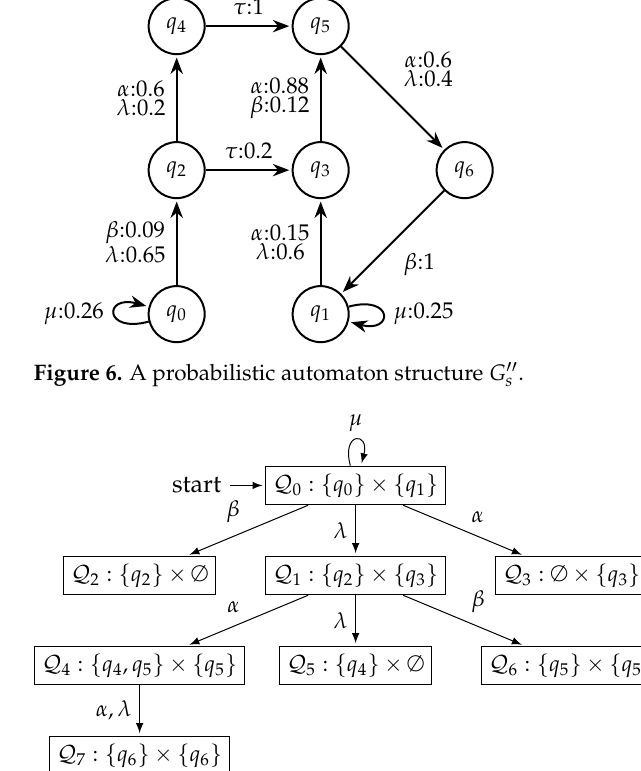
Figure 7. Verifier V ε for G (cid:48)(cid:48) ( q 0 ) and G (cid:48)(cid:48) ( q 1 )